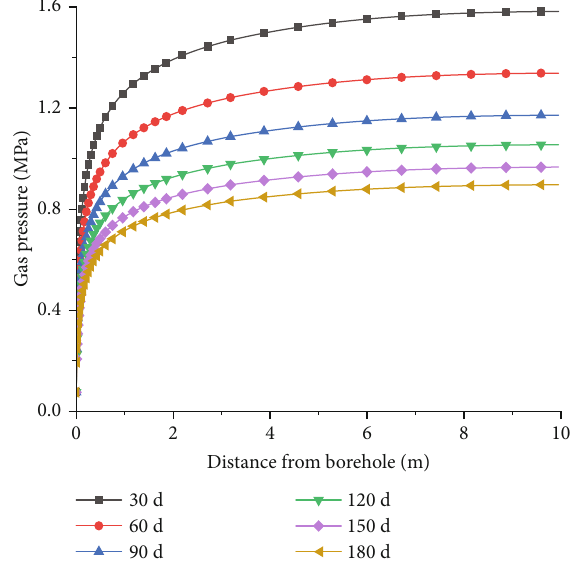
Figure 19: Variation curves for gas pressure after unloading disturbance.